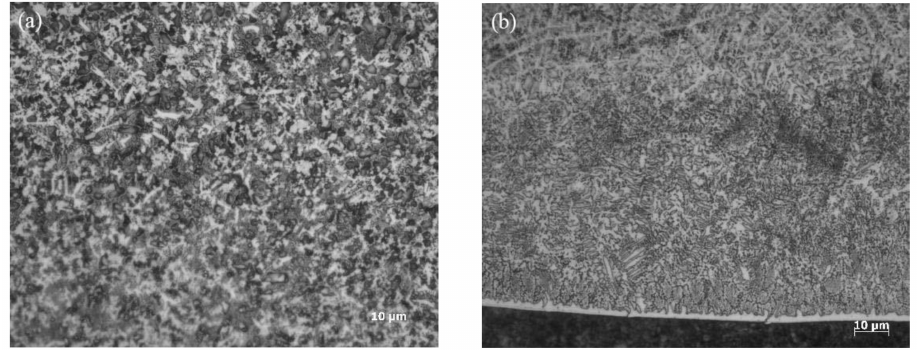
Figure 6. Sample structure with electromagnetic field assistance. ( a ) Microstructure at point A of Figure 5a; ( b ) microstructure at point D of Figure